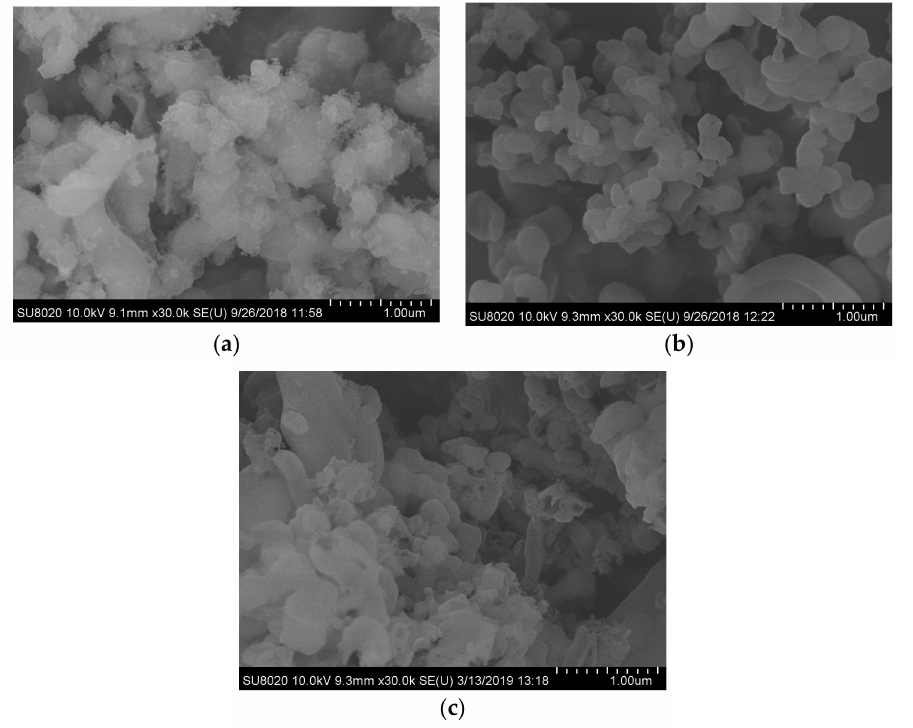
Figure 7. SEM images of MCM-41s: ( a ) MCM-41(0.1); ( b ) MCM-41(0.2); ( c )